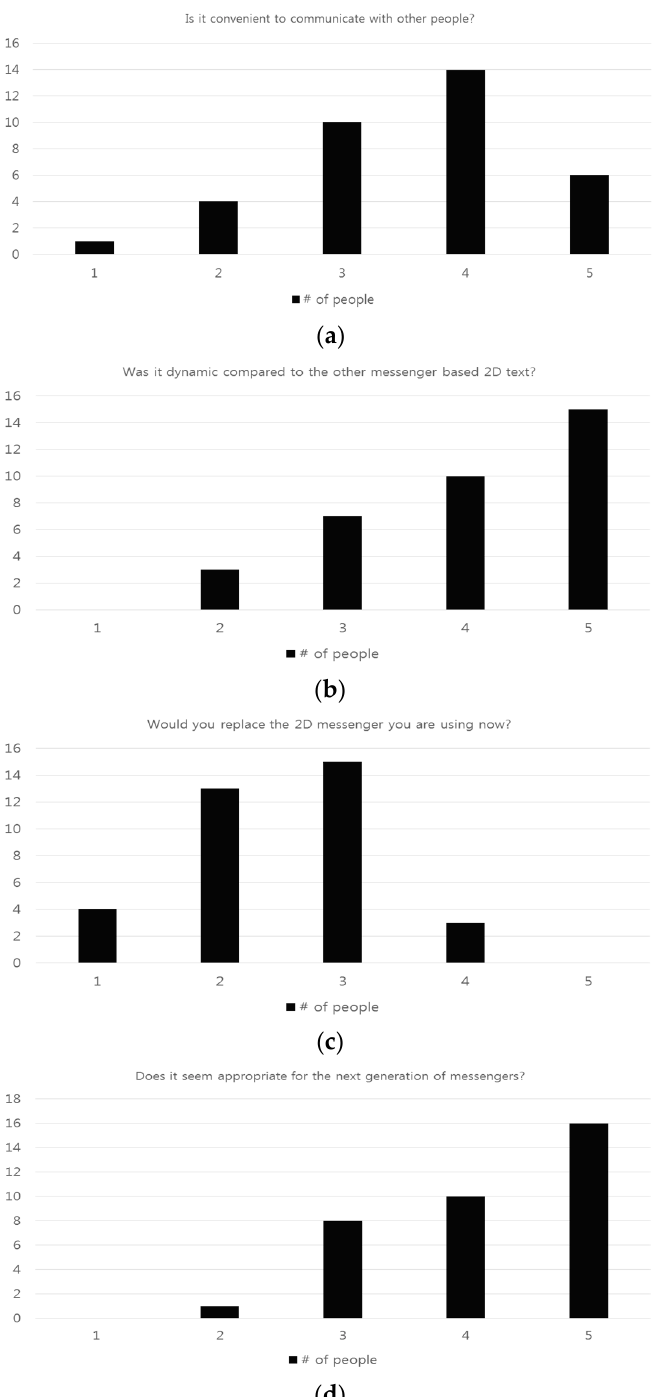
Figure 12. User validation of proposed messenger based on the following questions: (a) Is the application convenient to communicate with other people? (b) Is the application dynamic relative to other messengers based on 2D text? (c) Would you replace the 2D messenger you are using now? (d) Does it seem appropriate for the next generation of messengers?